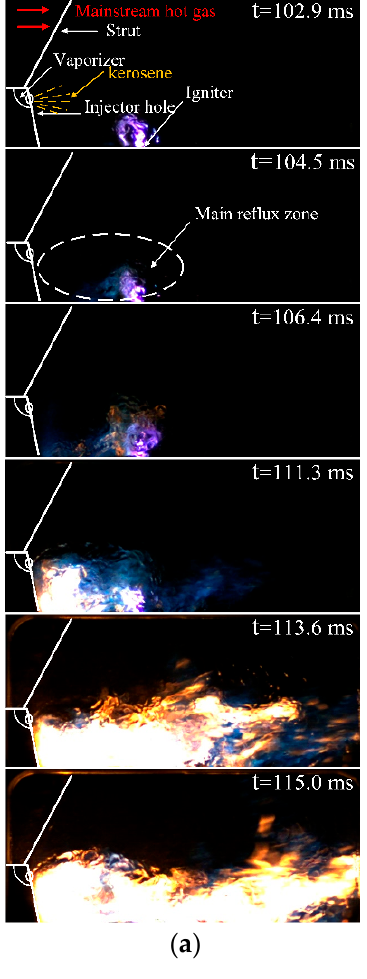
Figure 16. Flame propagation process under different oil–gas ratios (Ma = 0.1, total inlet temperature 420 K, Δ p = 350 Torr): ( a ) oil–gas ratio: 0.0035; ( b ) oil–gas ratio: 0.0043.